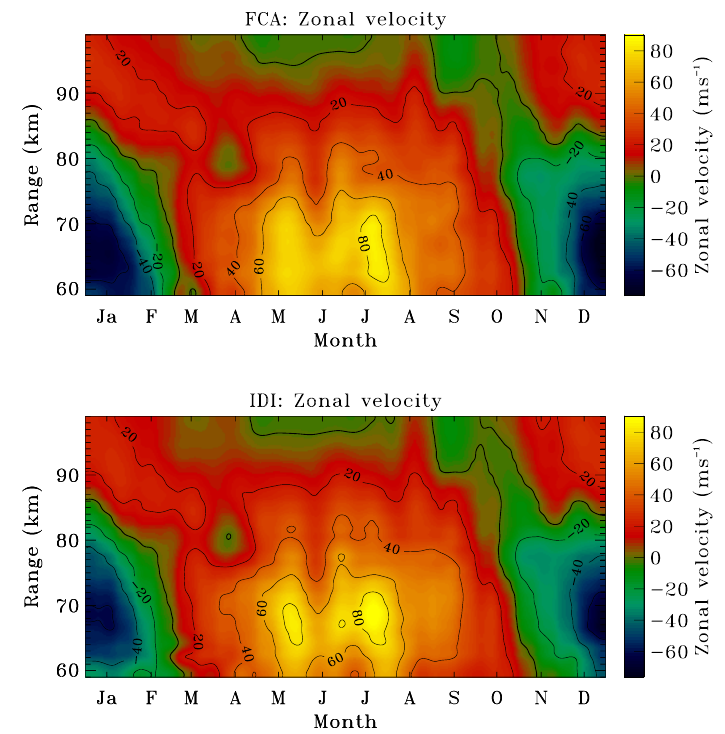
Fig. 7. Annually superposed fortnightly averaged FCA/IDI zonal winds.